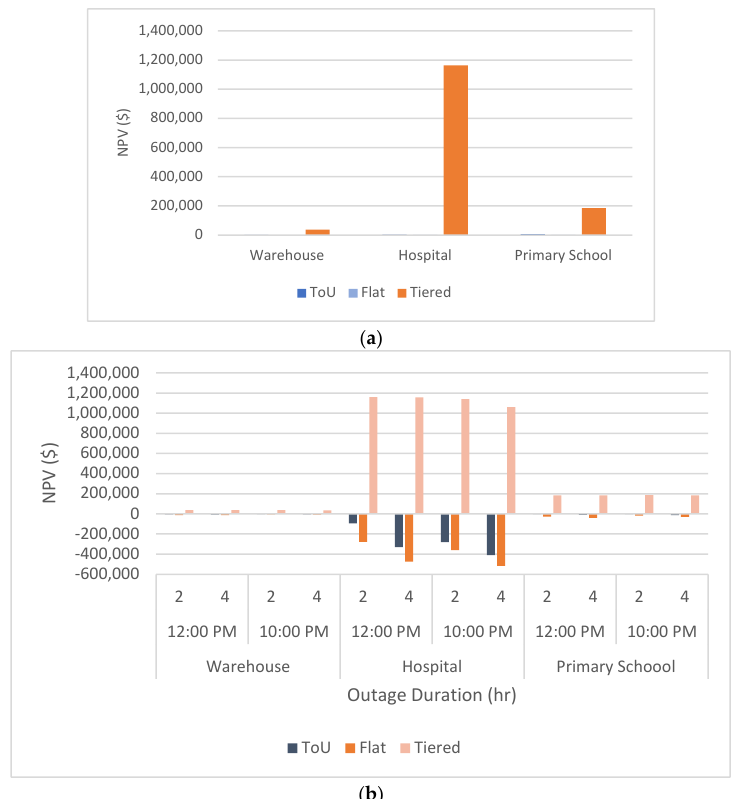
Figure 5. Boston, MA region—( a ) financial and ( b ) resilience results.